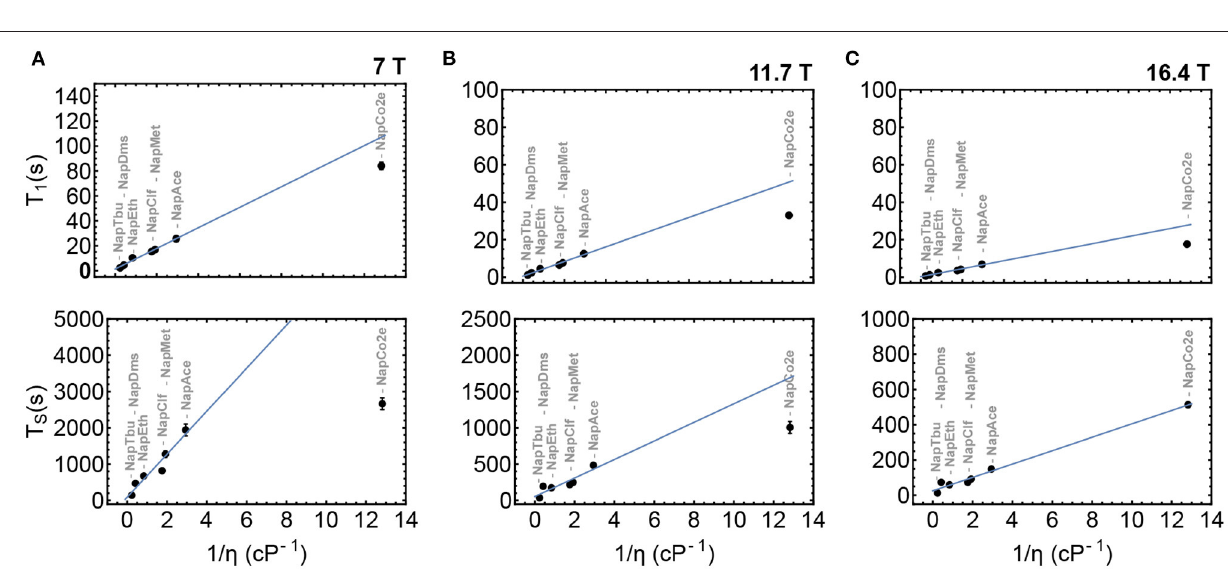
Frontiers in Chemistry |